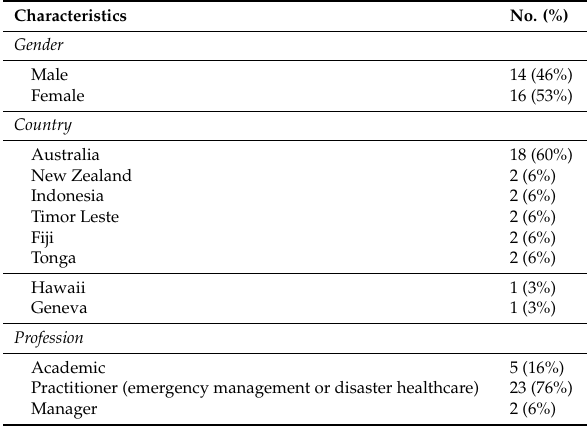
Table 1. Participant